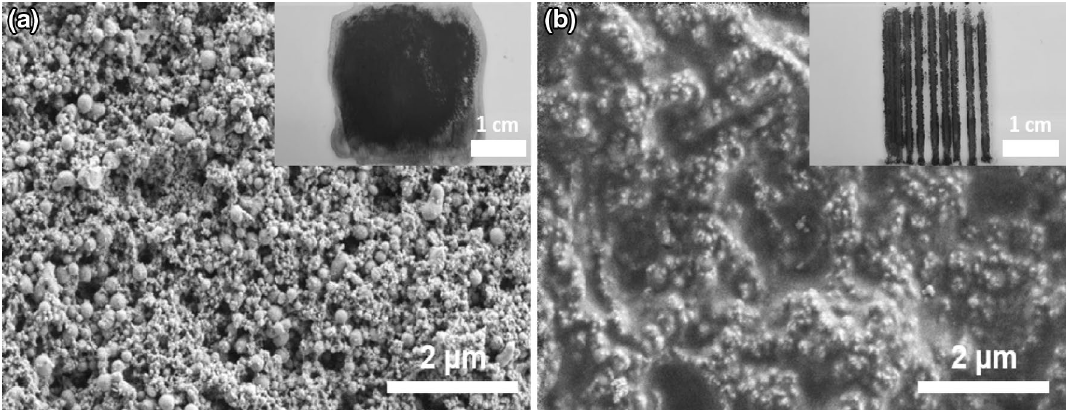
Figure 7. SEM image with respective light optical microscopy image of the drop-casted FeRh ethanol-based ink on a glass substrate ( a ) before and ( b ) after sintering with a CW-laser (0.85 W/mm 2